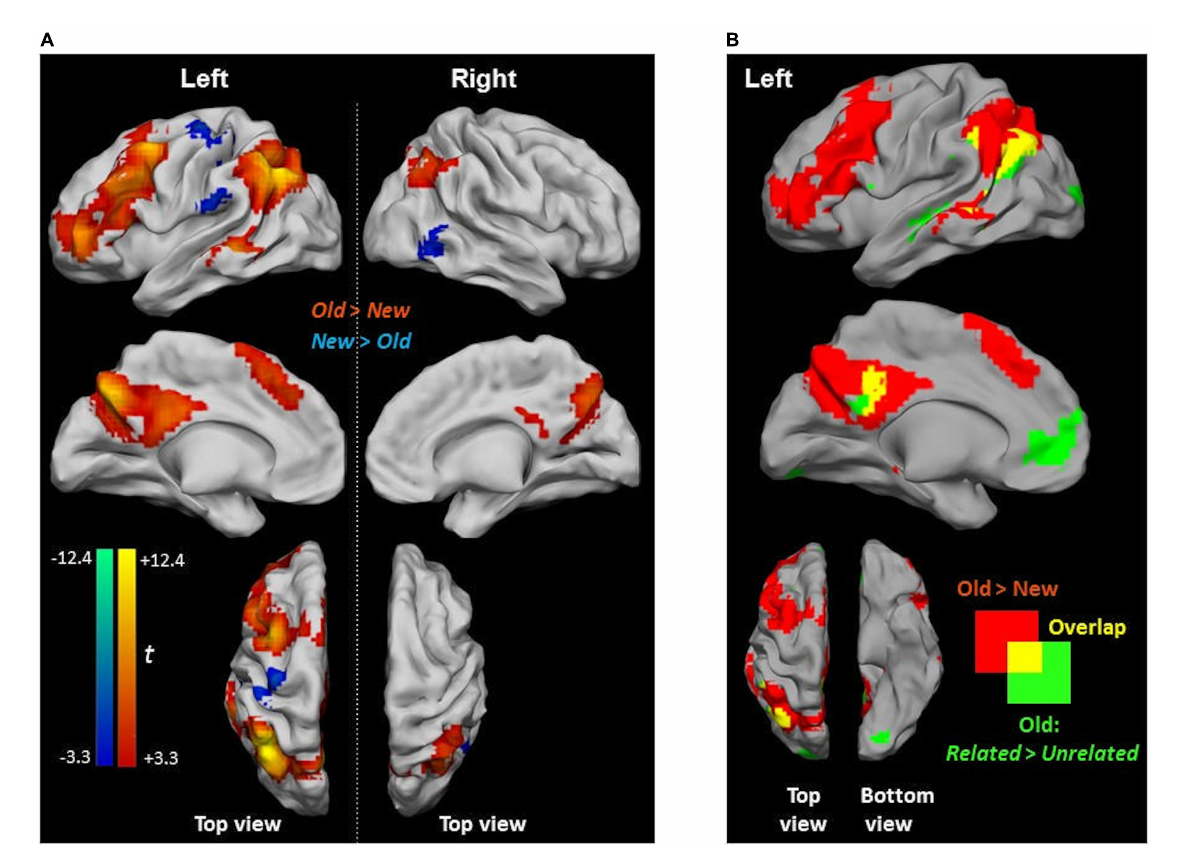
FIGURE5 Activity differences during picture-recognition . (A) Clusters showing significant activity for Old > New (red scale) and for New > Old (blue scale). Due to the large cluster size obtained at cluster-corrected thresholds, contrasts are reported at a stricter threshold of p < 0.05, voxel-wise FWE. (B) Overlap between Old > New (red) and Related > Unrelated (green) (from Figure 4C ) with the shared area shown in